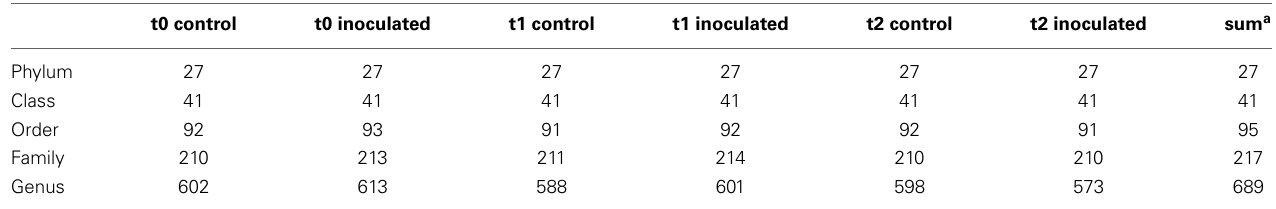
Table 4 | Numbers of different taxa assigned to the superkingdom Bacteria detected within the metagenome sequences as analyzed by the MG-RAST software